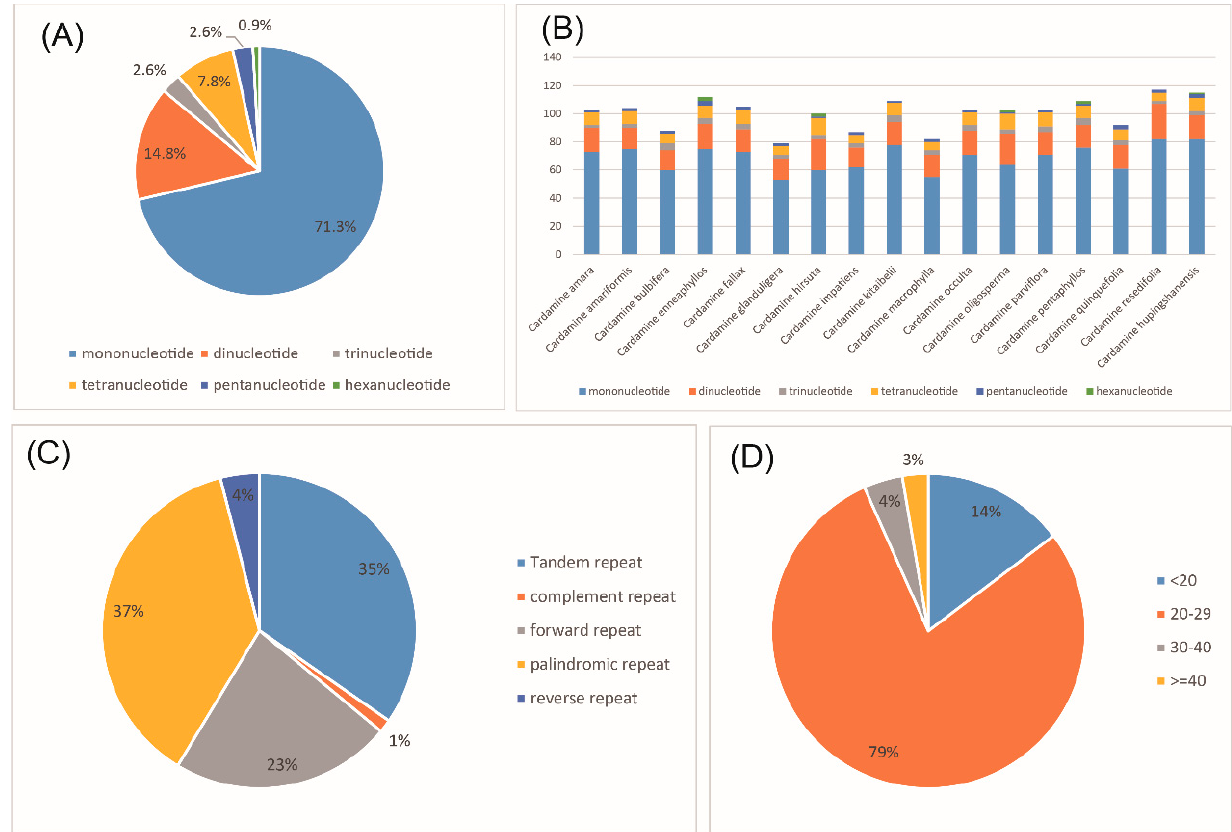
Figure 5. Long repeat and simple sequence repeat (SSR) types and distributions of C. hupingshanensis and other species in Cardamine . ( A ) Percentage of different SSR types in C. hupingshanensis ; ( B ) number of SSR types in Cardamine ; ( C ) number of different long repeat lengths in C. hupingshanensis ; ( D ) percentage of five long repeat types in C. hupingshanensis . Table 4. The polymorphic SSRs among 17 Cardamine species.